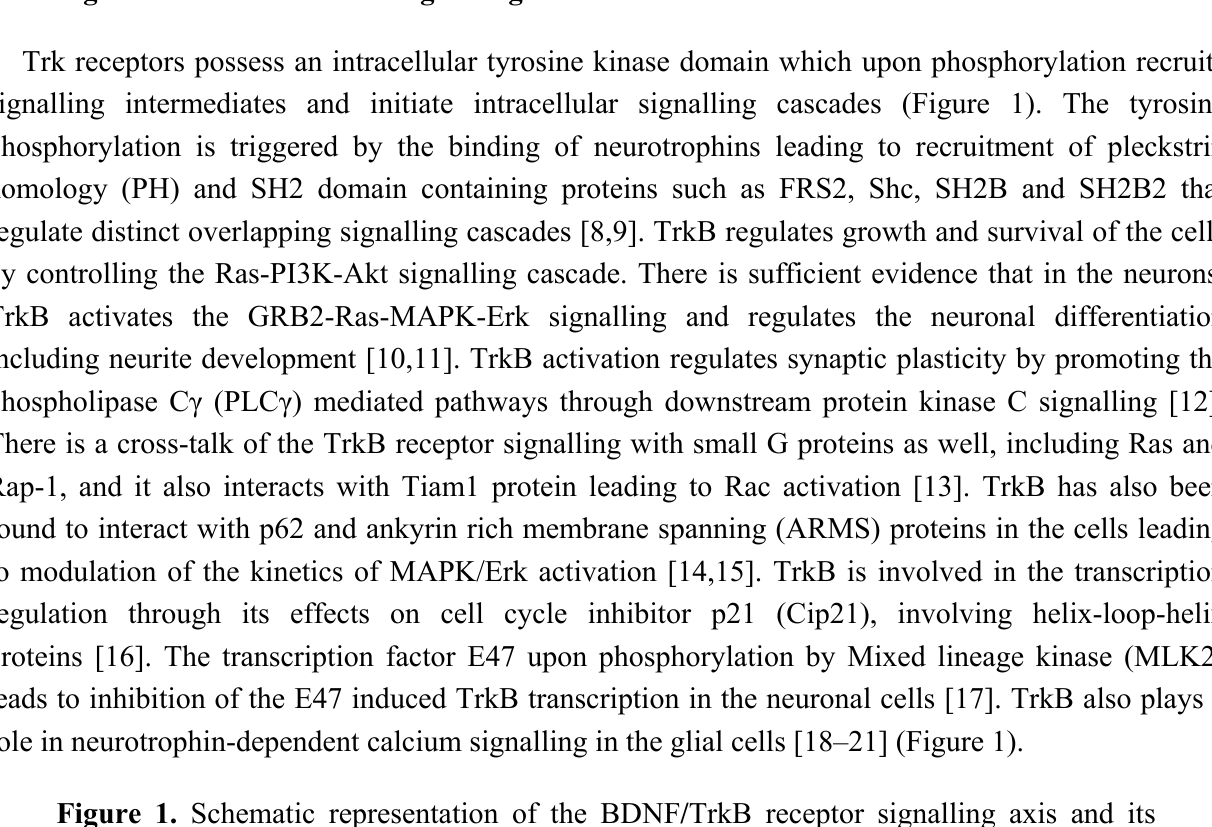
Figure 1. Schematic representation of the BDNF / TrkB receptor signalling axis and its downstream cellular effects. The binding of neurotrophic factors leads to auto-phosphorylation of the receptor intracellular domain. Cross-talk with other receptors and its regulation is shown. The internalization and transport of BDNF/TrkB in cells through endosomes is represented diagrammatically. P, Phosphorylation; Cav, Caveolin; IP3, Inositol tri-phosphate; CaM,